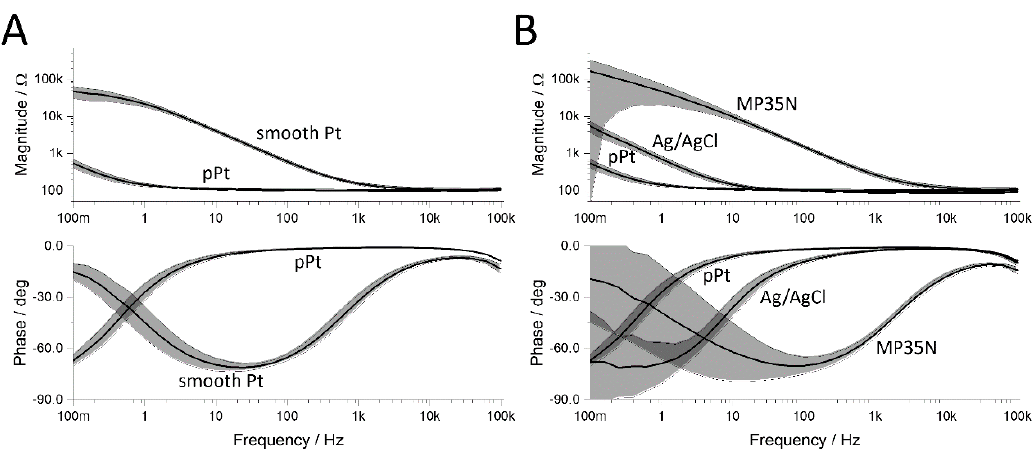
Figure 3. Electrochemical impedance measurement of different electrode materials. ( A ) Smooth platinum electrodes before and after electrochemical deposition of porous platinum (N = 10). ( B ) comparison of MP35N (N = 7), Ag/AgCl (N = 7) and porous platinum (pPt) electrodes of the same